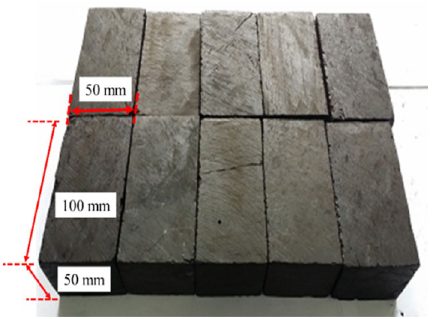
Figure 4. Physical object images and dimension of the coal specimens.